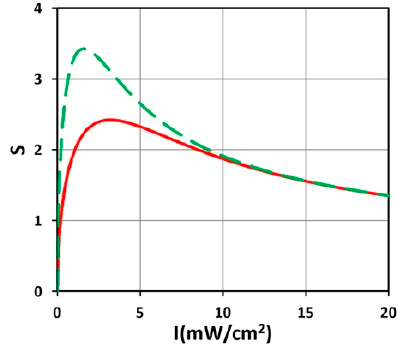
Figure 6. Steady-state S versus PI concentration (C 0 ), for z = 0 ( left figure ) and z = 0.5 cm ( right figure ), for D = 1.0 cm, I 0 = 10 mW/cm 2 .